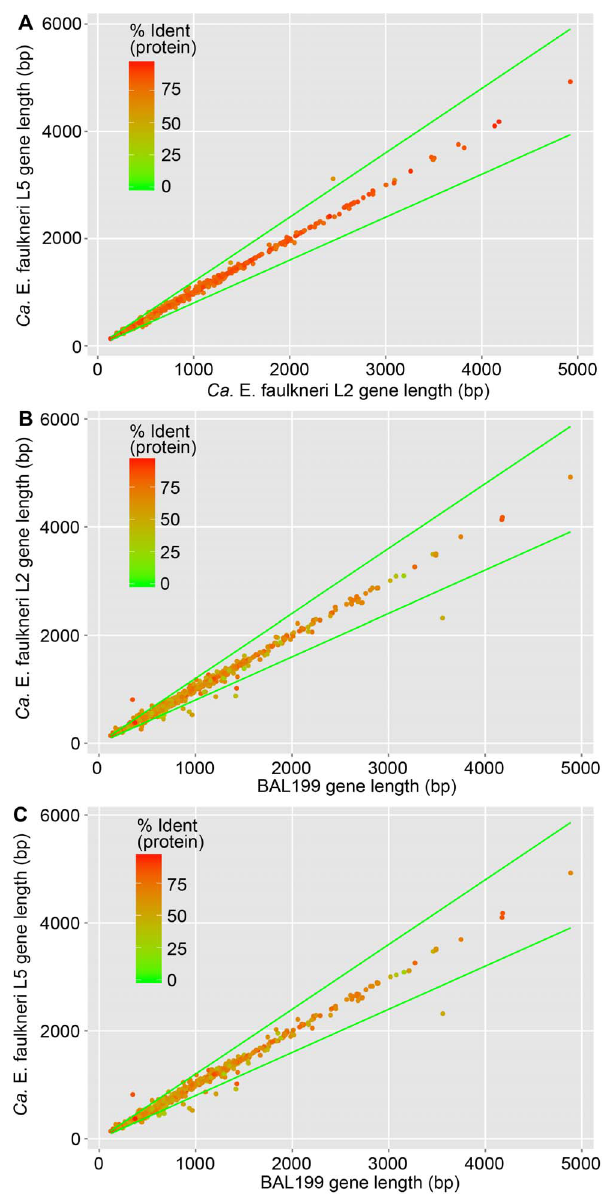
Figure 10. Only one gene varies in length by more than 20% in Ca. E. faulkneri strains L2 and L5, and only a few are truncated by more than 20% versus their homologs in BAL199. Comparisons shown: (A) Ca. E. faulkneri L2 and L5, (B) Ca. E. faulkneri L2 and BAL199, and (C) Ca. E. faulkneri L5 and BAL199. Green lines denote a tolerance of 6 20% of the x -axis variable. Note: the large PKS genes in the ptz pathway are omitted in order to avoid skewing the scale of axes in